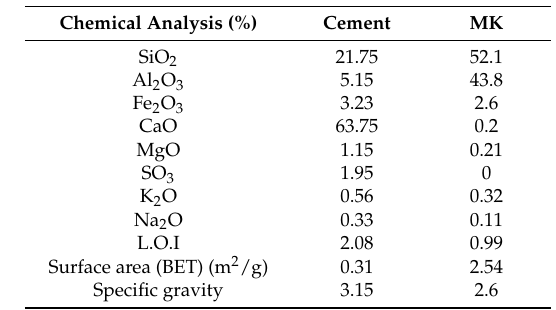
Table 2. Properties of nano-CuO product.